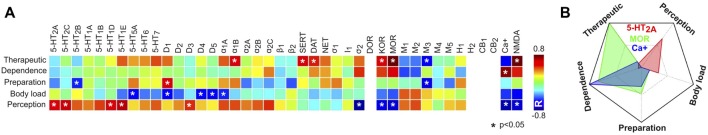
Correlations between receptor binding affinities and principal component scores. (A) Matrix containing the Pearson’s linear correlation coefficients between principal component scores (rows) and binding affinities (columns) at the 42 sites, computed across 18 psychedelic compounds (Ray, 2010). Blank spaces indicate that it was not possible to compute the linear correlation value due to missing data. (B) Radar plot showing the correlations in (A) for three binding sites with different profiles (5-HT2A binding affinity presented the highest correlation with the “perception” component scores, mu opioid receptor (MOR) with the “therapeutic” and “dependence” component scores, and Ca+ with the “dependence” component scores).